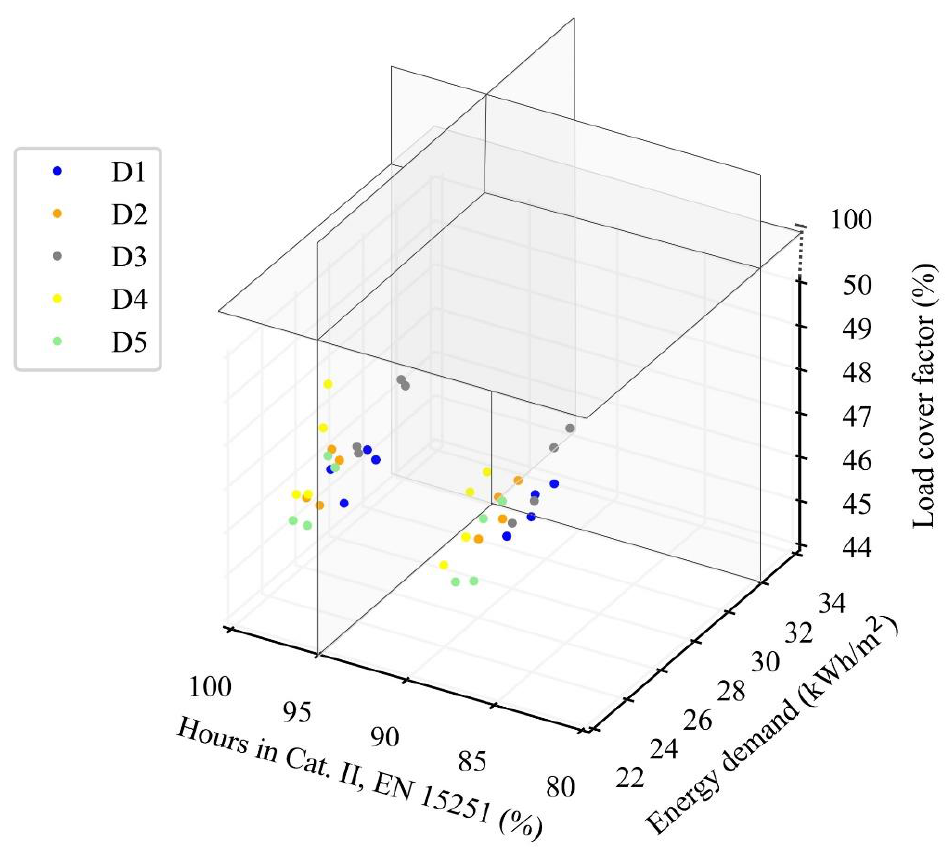
Figure 6. Energy demand vs. percentage of hours in Category II of EN 15251 vs. load cover factor, for the five designs across the eight scenarios. The three highlighted planes show the robustness margins for each indicator.